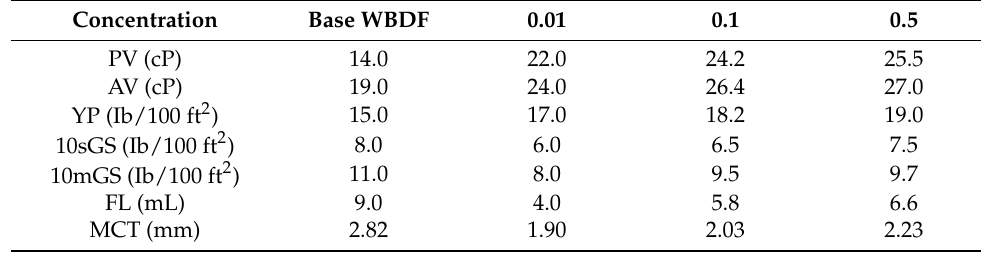
Table 4. Rheological properties of welding waste-derived